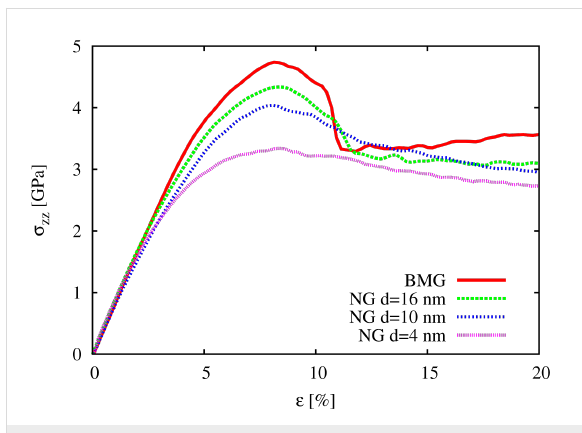
Figure 1: Tensile stress–strain curves for a BMG in comparison to three NGs with grain sizes of 4 nm, 10 nm and 16 nm, respectively, at a constant strain rate of 4 · 10 7 s − 1